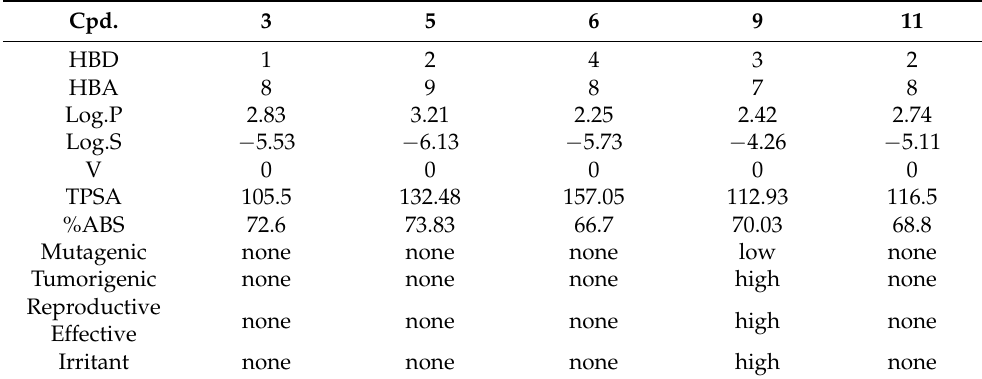
Table 3. Drug likeness parameters and derived for 3 , 5 , 6 , 9 , and 11 ligands.